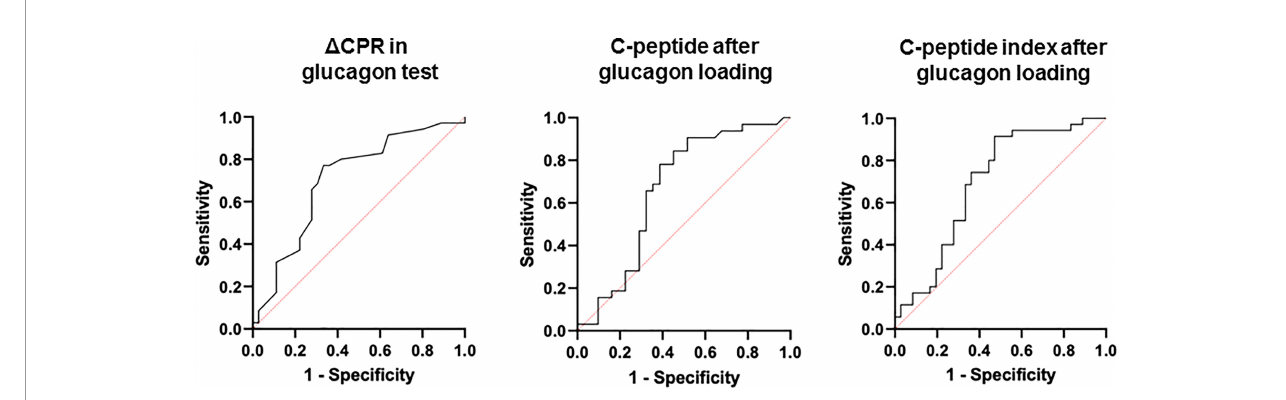
FIGURE 2 | ROC curves to determine cutoff values of each indicator for withdrawal from insulin therapy.